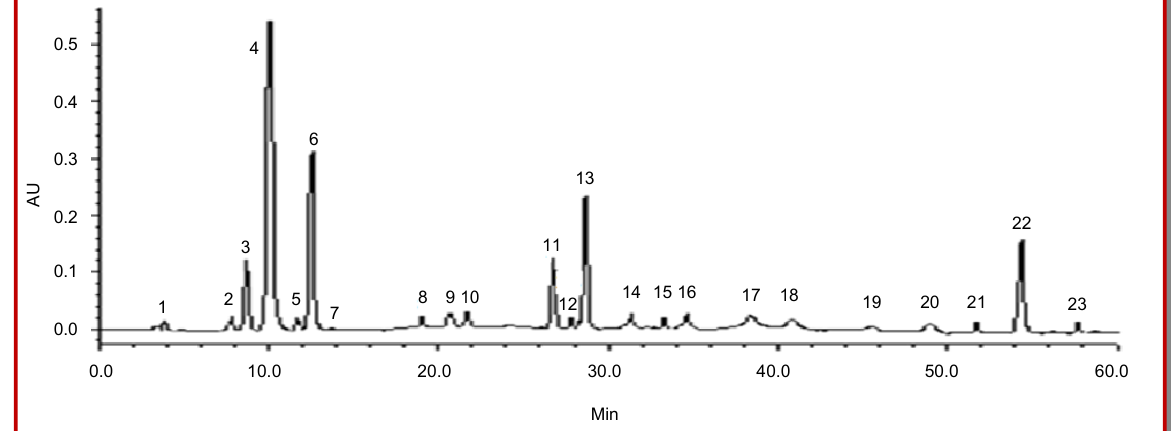
Figure 1: HPLC profile of hydromethanolic extract of P. coulteri